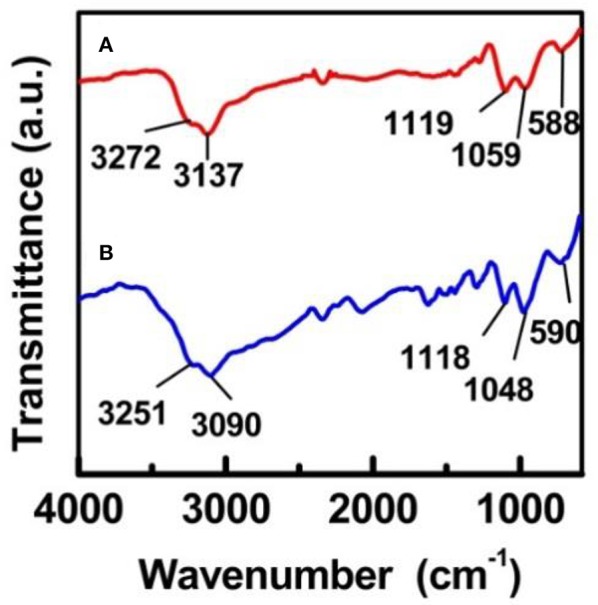
FT-IR spectra of (A) Fe-SBA15-HSO3BM and (B) Fe-SBA15-HSO3
BM−IM.